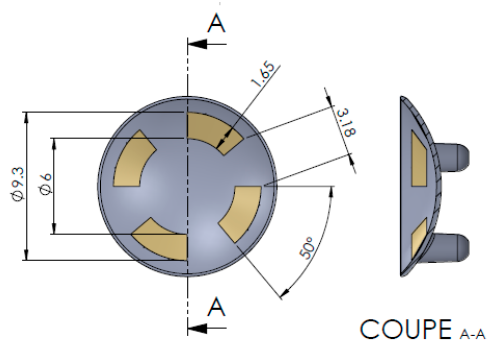
Figure 5. Diagram of an Impedance Eye Recording (IER) Lens injected in Styrene-Methyl Methacrylate (SMMA) with thin gold layer electrodes.